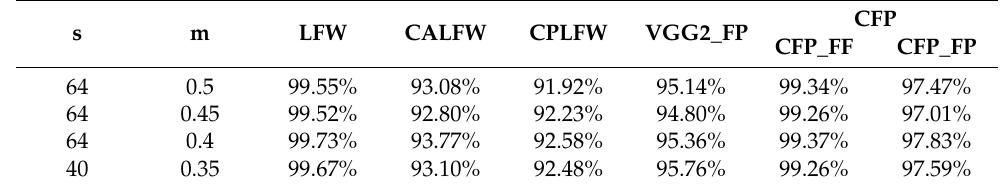
Table 5. The ablation study on different hyperparameters s and m with ResNet-100. The VGGFace2 dataset, which is relatively small in size, is chosen for the training dataset.